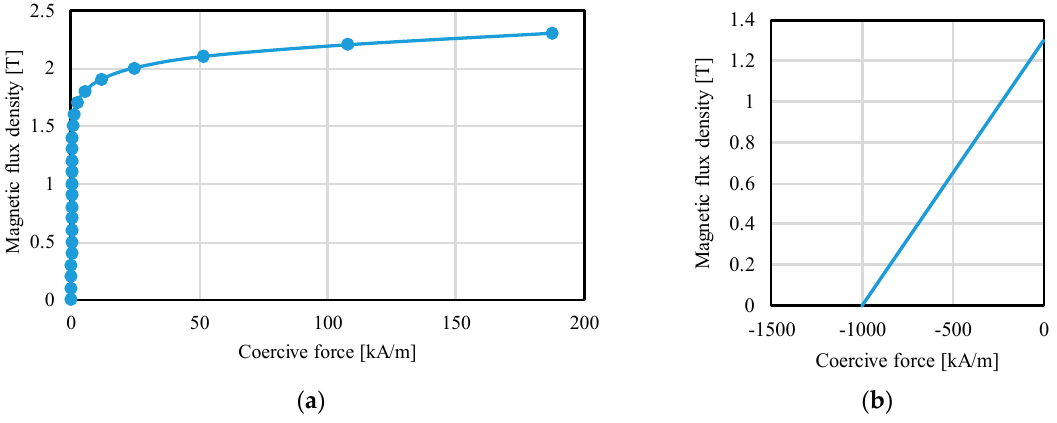
Figure 12. Magnetic characteristics of the magnetic material. ( a ) Yoke; ( b ) Permanent magnet.